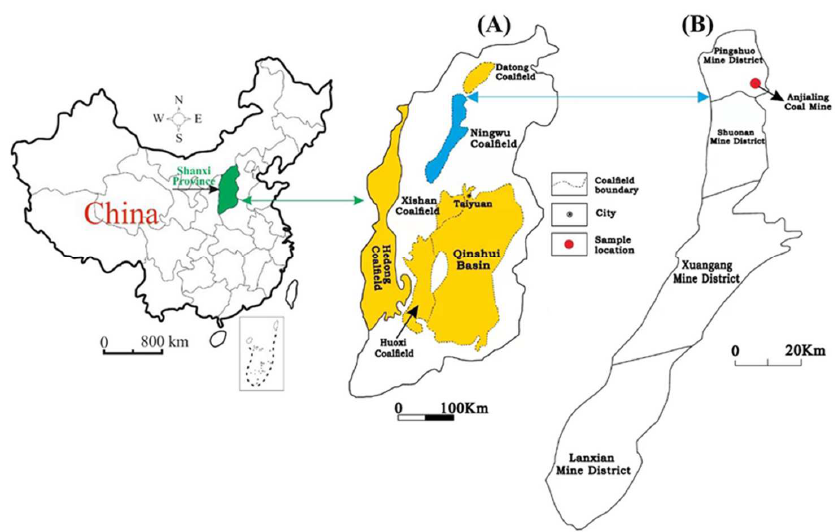
Figure 1. ( A ) The location of the Ningwu coalfield and the distribution of the major coalfields in Shanxi Province, China; ( B ) the Ningwu coalfield with the location of the Anjialing mine [30].